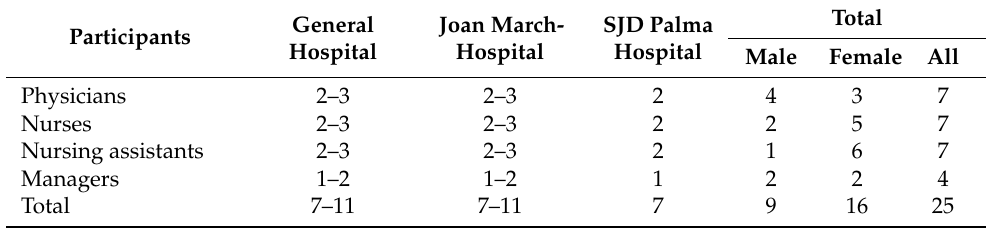
Table 1. Profile of participants.